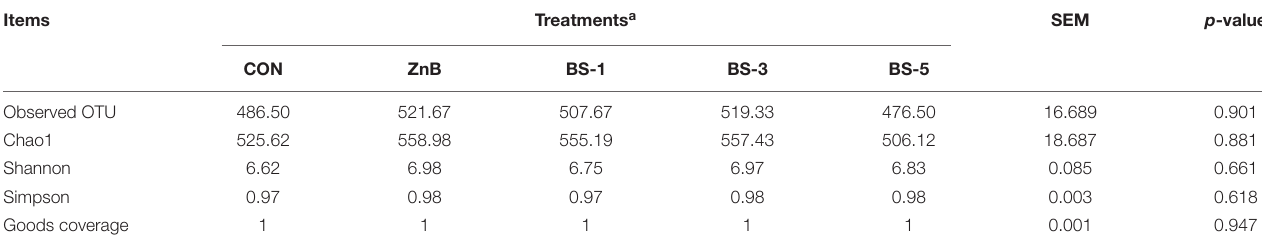
TABLE 6 | Effect of dietary supplementation of Bacillus subtilis ATCC19659 on cecal microbiota communities of broilers by alpha diversity measures. Items Treatments a